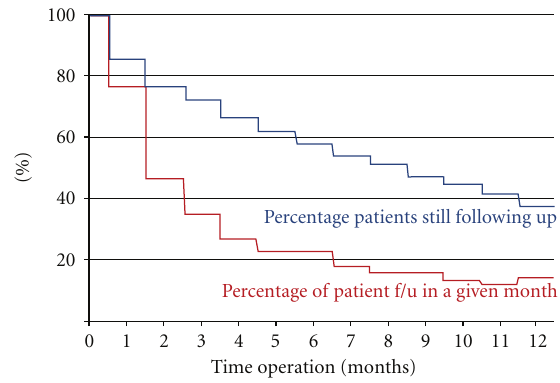
Figure 1: Follow-up diagram. This diagram outlines the percentage of patients that were still following up in our database (blue). The diagram also notes the percentage of patients following up in any given month after surgery (red). f/u: